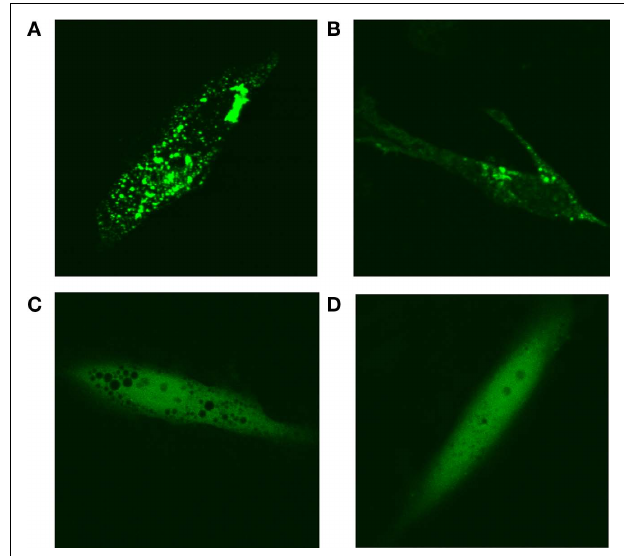
FIGURE 13 | MTHFS-GFP forms clusters in purine-depleted media during G 1 -phase of the cell cycle. The MTHFS-GFP fusion protein (shown in green) was expressed in HeLa cells maintained in either purine-depleted RPMI-1640 medium as described in Section “Materials and methods.” 24h prior to visualization, cells were treated with 60 μ M mevinolin (lovastatin) to arrest in G 1 -phase (A, B) or 120ng/mL nocodazole to arrest at G 2 /M (C, D) . Cell-cycle arrest was confirmed by